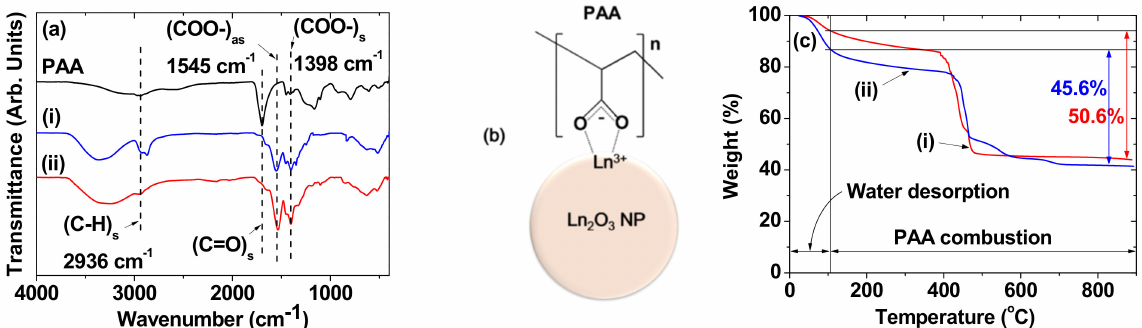
Figure 4. ( a ) FTIR absorption spectra of the powder samples and free PAA, ( b ) bridge-bonding structure of COO − with Ln 3+ on a NP surface (many such bridge-bonding structures exist per NP because of many COO − groups per PAA and many Ln 3+ on a NP surface), and ( c ) TGA curves of the powder samples: the numbers are the amounts of PAA-coating in wt.%. Labels (i) and (ii) indicate the PAA-coated Ln 2 O 3 NPs [Ln = (i) Tb and (ii)